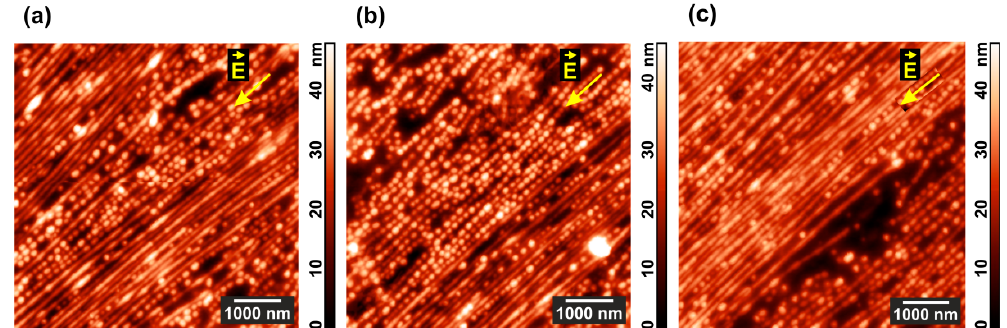
Figure 4. AFM images of the areas with a predominance of ( a ) horizontal and ( b ) vertical morphology in PS-P4VP/AuNR films annealed for 24 h under chloroform vapor and DC field. ( c ) The film surface after additional 96 h of the same treat- ment.